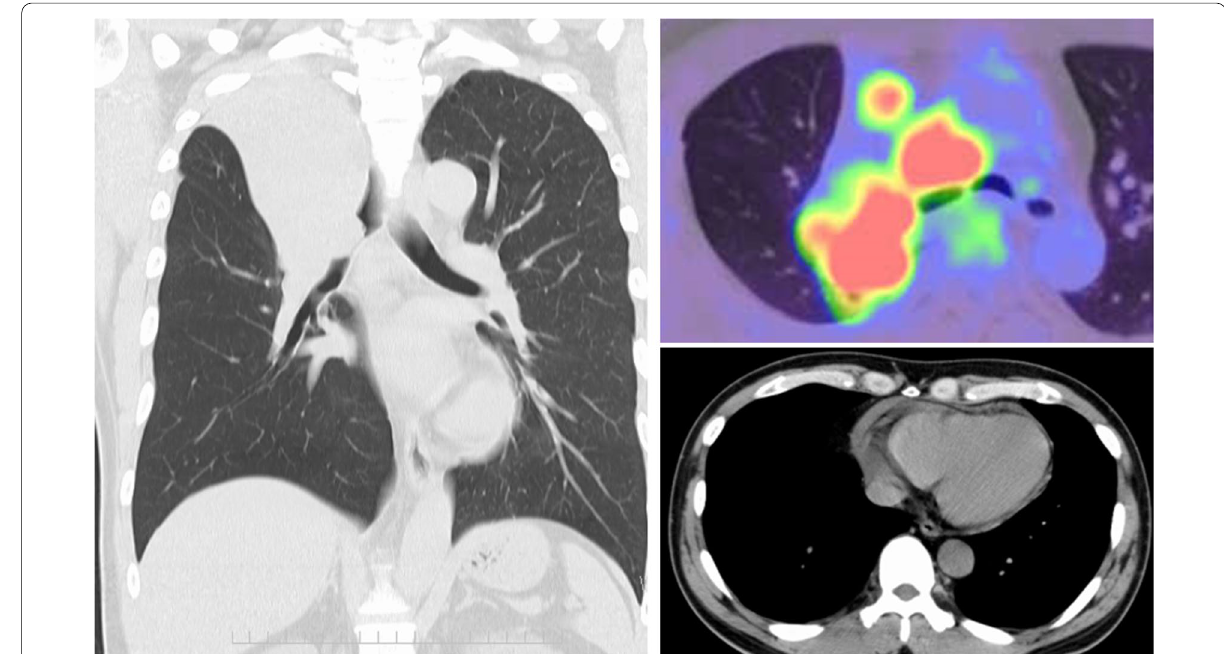
Fig. 1 Computed tomography and positron emission tomography at initial diagnosis revealed a large tumor obstructing the right main bronchus (left), enlarged upper and lower paratracheal nodes with strong uptake of fluorodeoxyglucose (right upper), and pericardial effusion (right